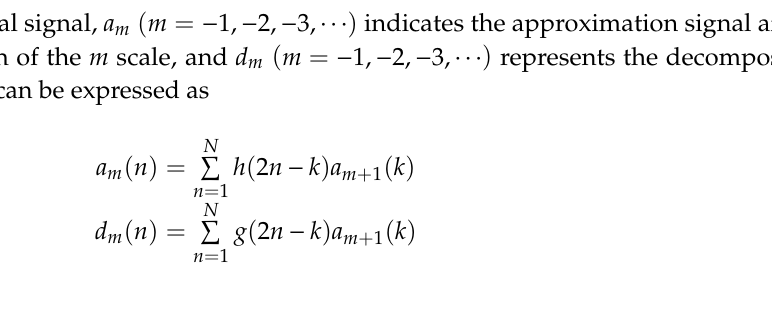
Figure 5. Wavelet transform: ( a ) decomposition algorithm; ( b ) reconstruction algorithm.